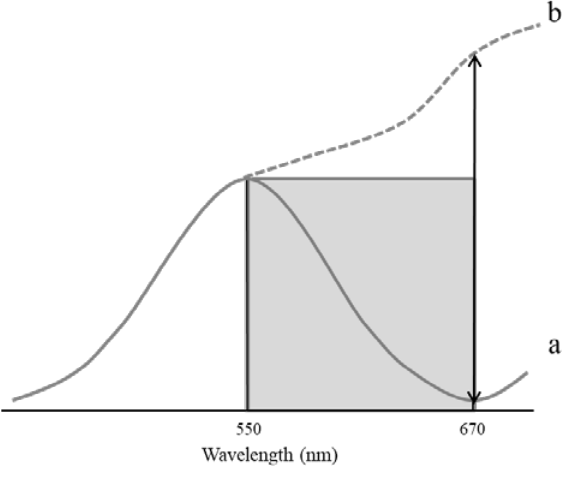
Figure 2. Reflectance variation between healthy (a) and wilting (b) vegetation.